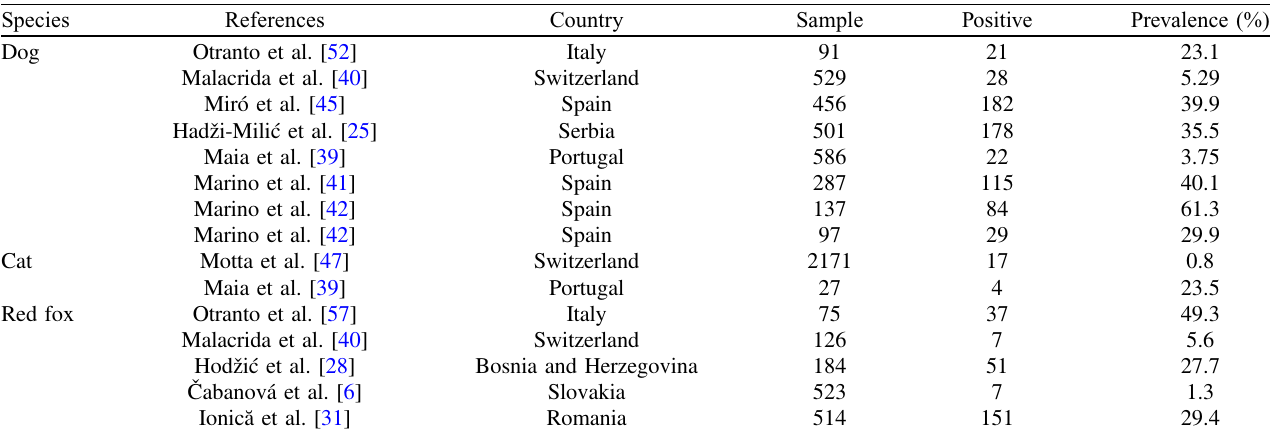
Table 4. Quantitative analysis regarding the main features of the studies about T . callipaeda infection in dogs, cats and red foxes in Europe.